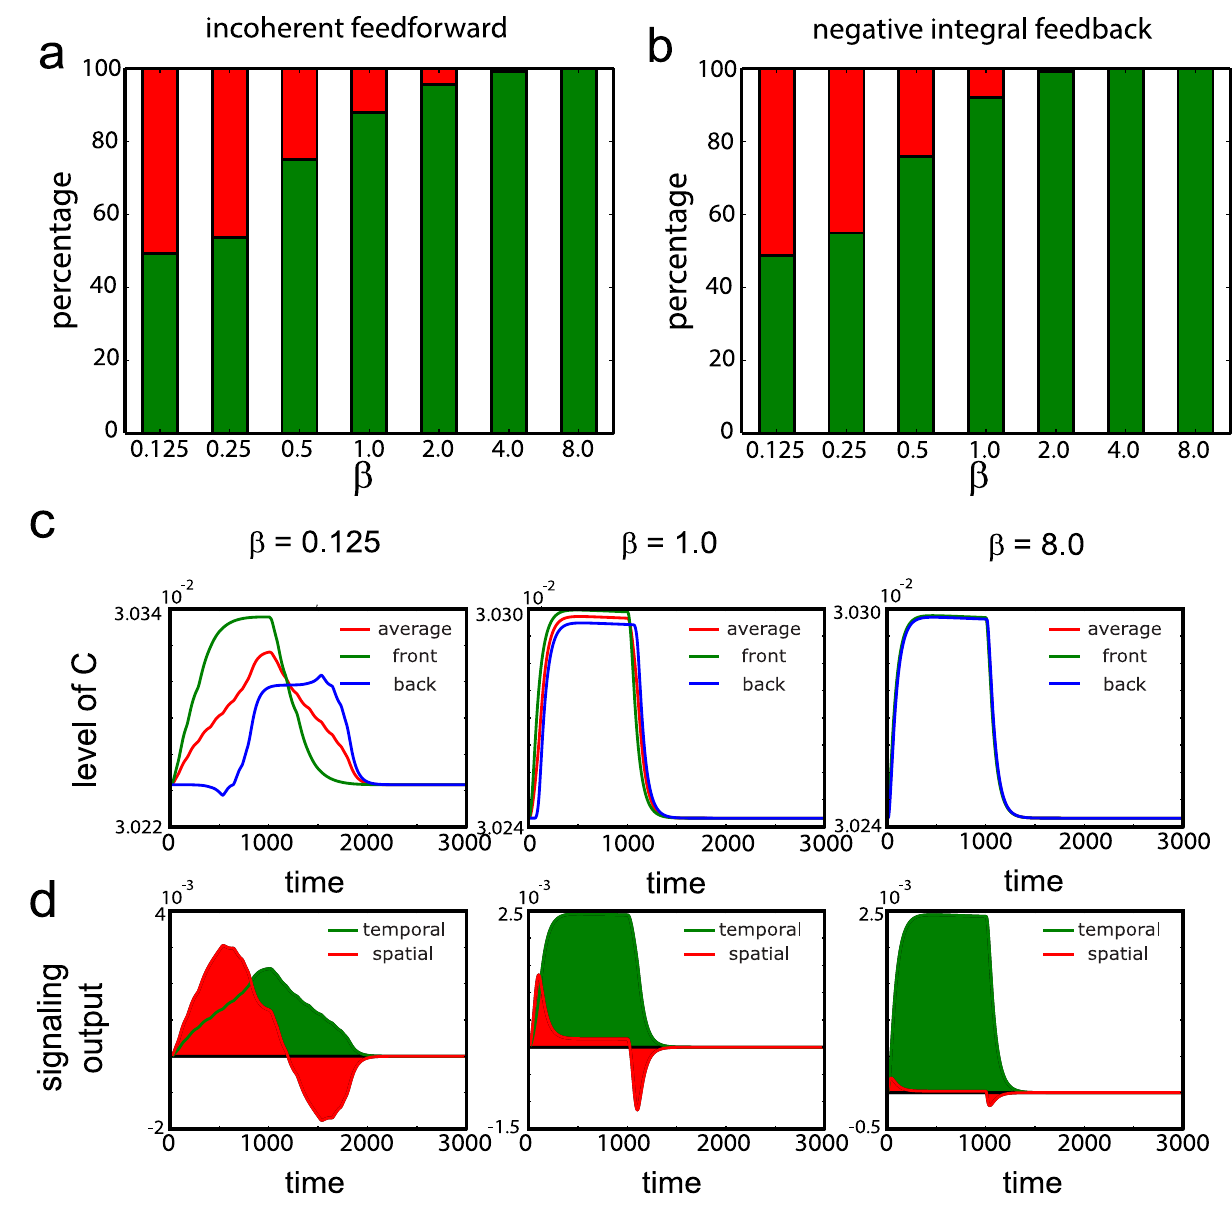
Fig 3. Temporal sensing is favored at high ratio of cell speed over cell size. Percentage of runs where temporal sensing yield high output (green) or spatial sensing yield high output (red) for (a) incoherent feedforward and (b) negative integral feedback circuits at different values of β . The range of D 0 A and D 0 values used are D 0 ¼ 0 : 1 ; 1 : 0 ; 10 ; 100 ; 1000 and D 0 ¼ 0 : 1 ; 1 : 0 ; 10 ; 100 ; 1000 . (c) Dynamics of the average level of protein C (red), level of B A B protein C at the front (green) and back (blue) for different values of β for the incoheret feedforward circuit with D 0 ¼ D 0 ¼ 1 : 0 . (d) Output from A B temporal (green) and spatial sensing (red) for the different values of β . halves of the cell experience a big delay in the time that they observe the chemoattractant and the levels of the output protein, C , at the rear end (blue curve) of the cell only increase after the level of C at the front end (green curve) starts to decrease (Fig 3c, left). The average level of C (red curve), which sums over the two halves, shows a net increase at all times when the cell is moving through the gradient. As β increases, the time difference in which the front and back